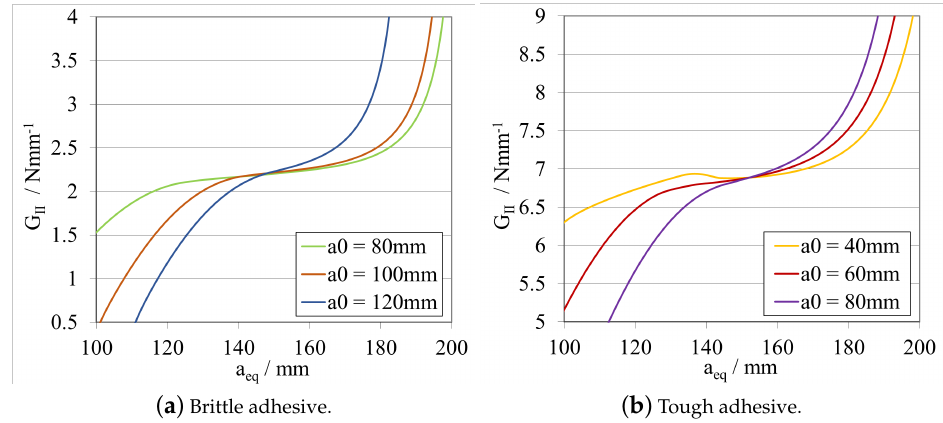
Figure 9. R-curves related to the a 0 ELS